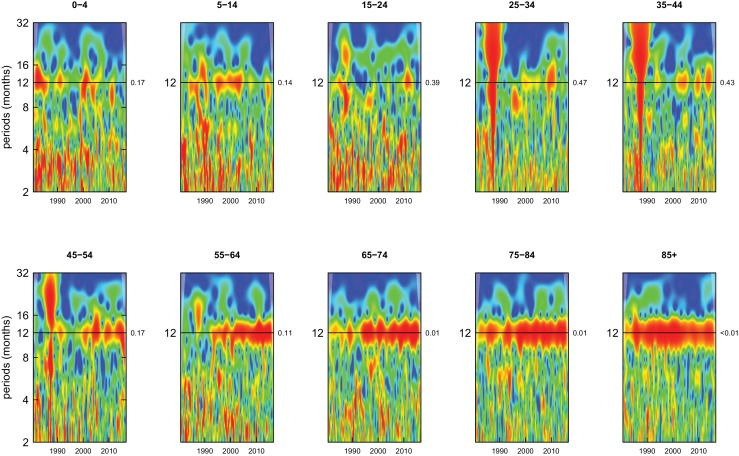
Wavelet power spectra for national time series of endocrine disorder death rates for 1980–2016, by age group for males.Wavelet power values increase from blue to red. The shaded regions at the left and right edge of each box indicate the cone of influence, where spectral analysis is less robust. P-values for the presence of 12 month seasonality are to the right of each figure at the 12 month line.